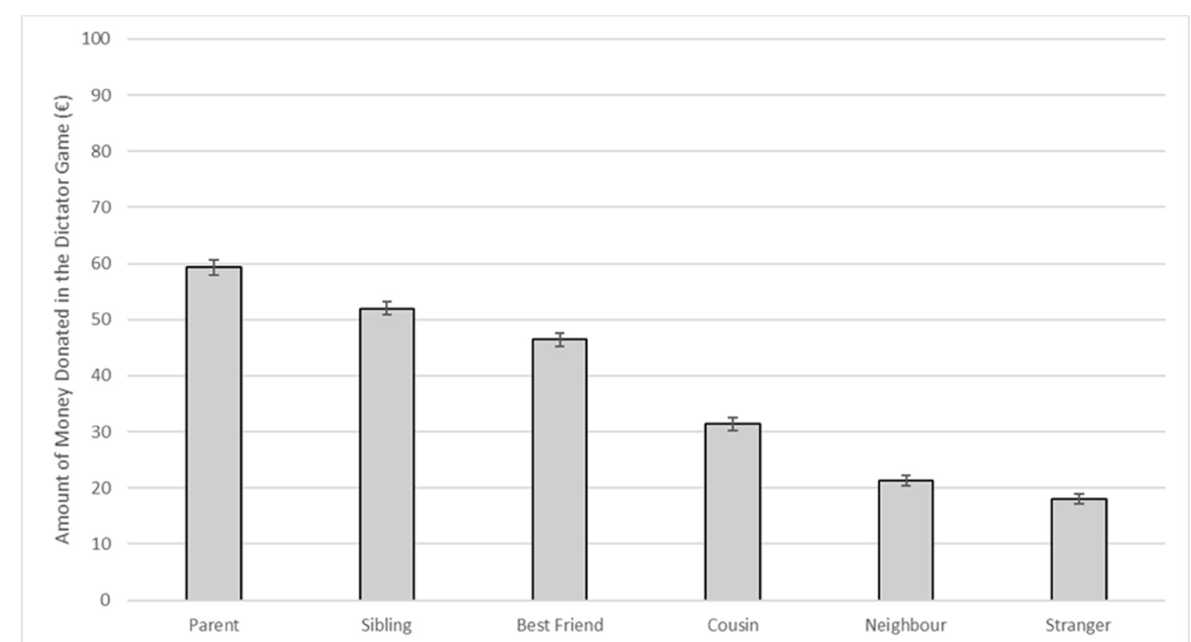
Figure 1. Means and standard errors of the amounts of money donated to each recipient by partici- pants during the dictator game ( n = 460). Table 2. Descriptive characteristics of the sample ( n =